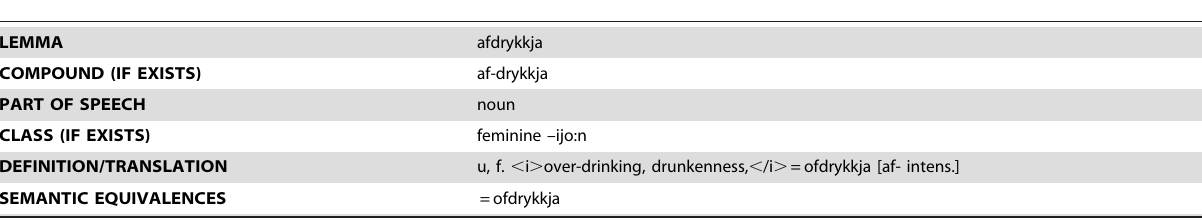
Table 2. Sample source entry for lemma afdrykkja .